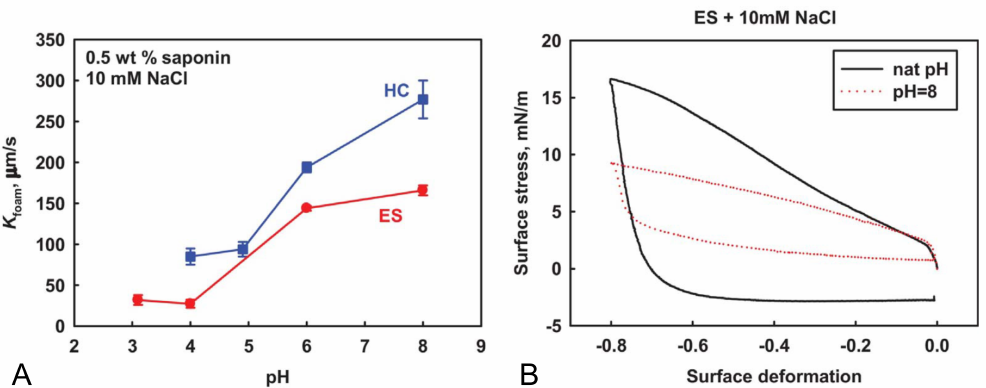
Figure 5. The figure shows in ( A ) the gas permeability ( K foam ) as a function of pH of the solution for foams stabilized by either the horse chestnut tree extract (HC, blue squares) and the pure saponin β -aescin (red dots). In ( B ) the surface stress is plotted against the surface deformation for β -aescin adsorption layers formed from solutions with natural pH (pH = 3.1) and adjusted pH of 8.0. Reprinted from Colloids and Surfaces A, 534, Tcholakova et al. [40], Role of surface properties for the kinetics of bubble Ostwald ripening in saponin-stabilized foams , pp. 16–25, ©2017, with permission from